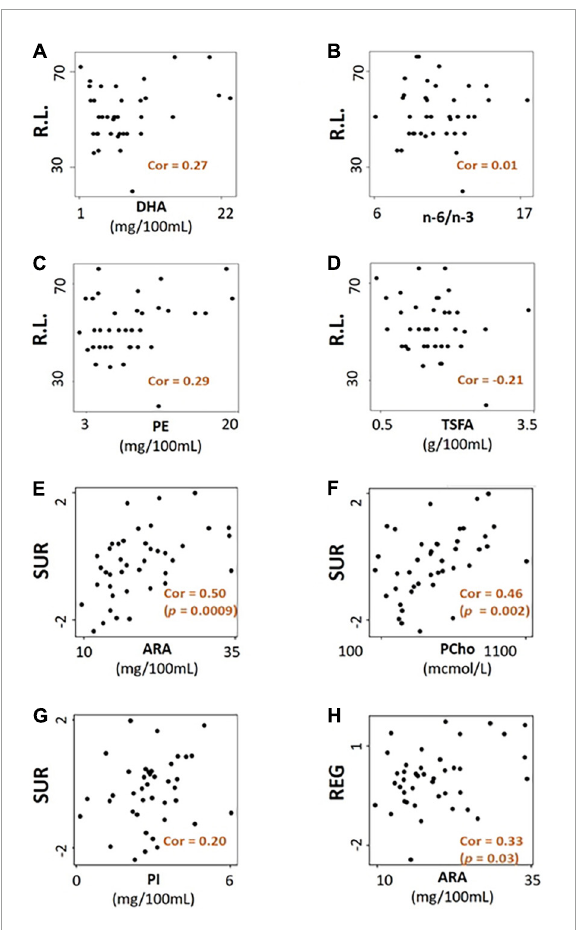
FIGURE5 The scatterplots of selected nutrients for receptive language score (R.L.) are shown in panels (A–D) , surgency (SUR) in panels (E–G) , and regulation (REG) in panel (H) mcmol,